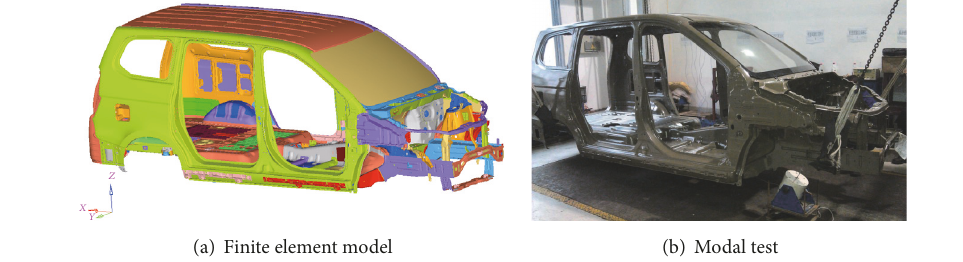
Figure 7: Body in white.